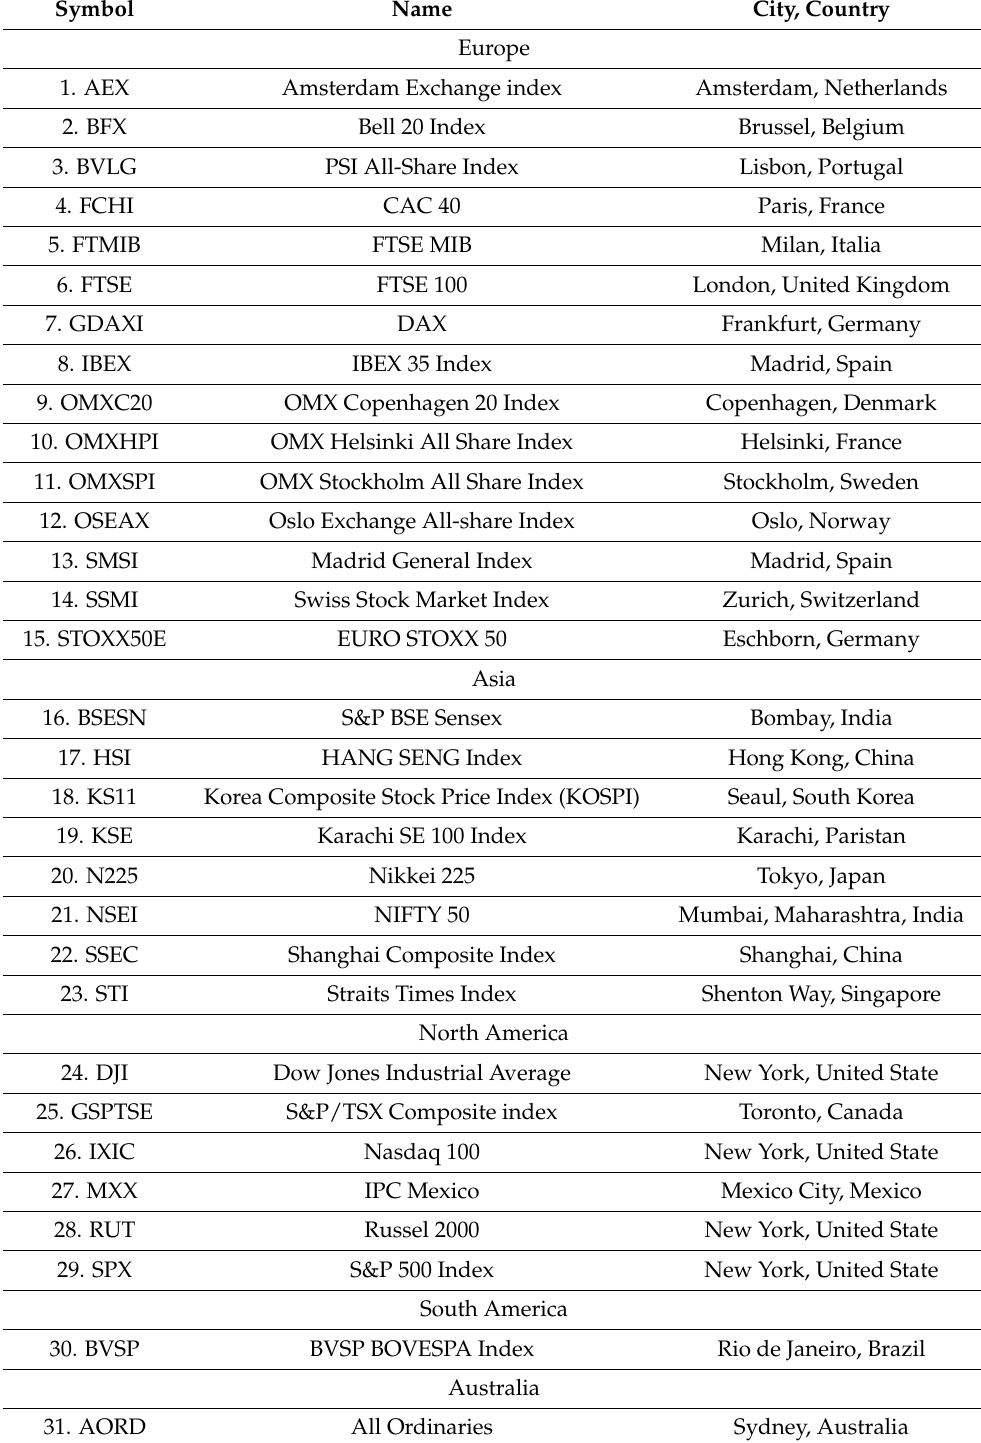
Table A1. Acronyms for each stock market